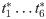
The spectrogram of the song of the bird “lny64”, used as an example
throughout this paper.This image was made by superposing the spectra of our 2818 aligned songs. Our example detection points, t1*…t6*, are shown as red lines, with example recognition regions of 30 ms × 1–8 kHz marked as rectangles.